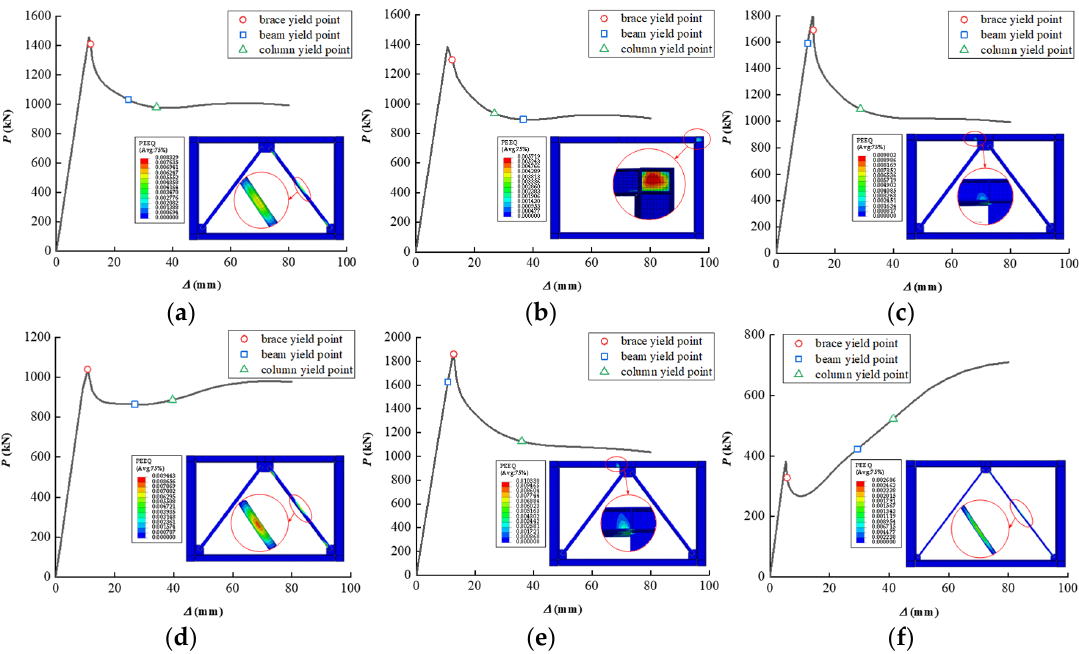
column web; ( c ) case 20, thicker braces; ( d ) case 23, thinner braces; ( e ) case 26, larger brace external